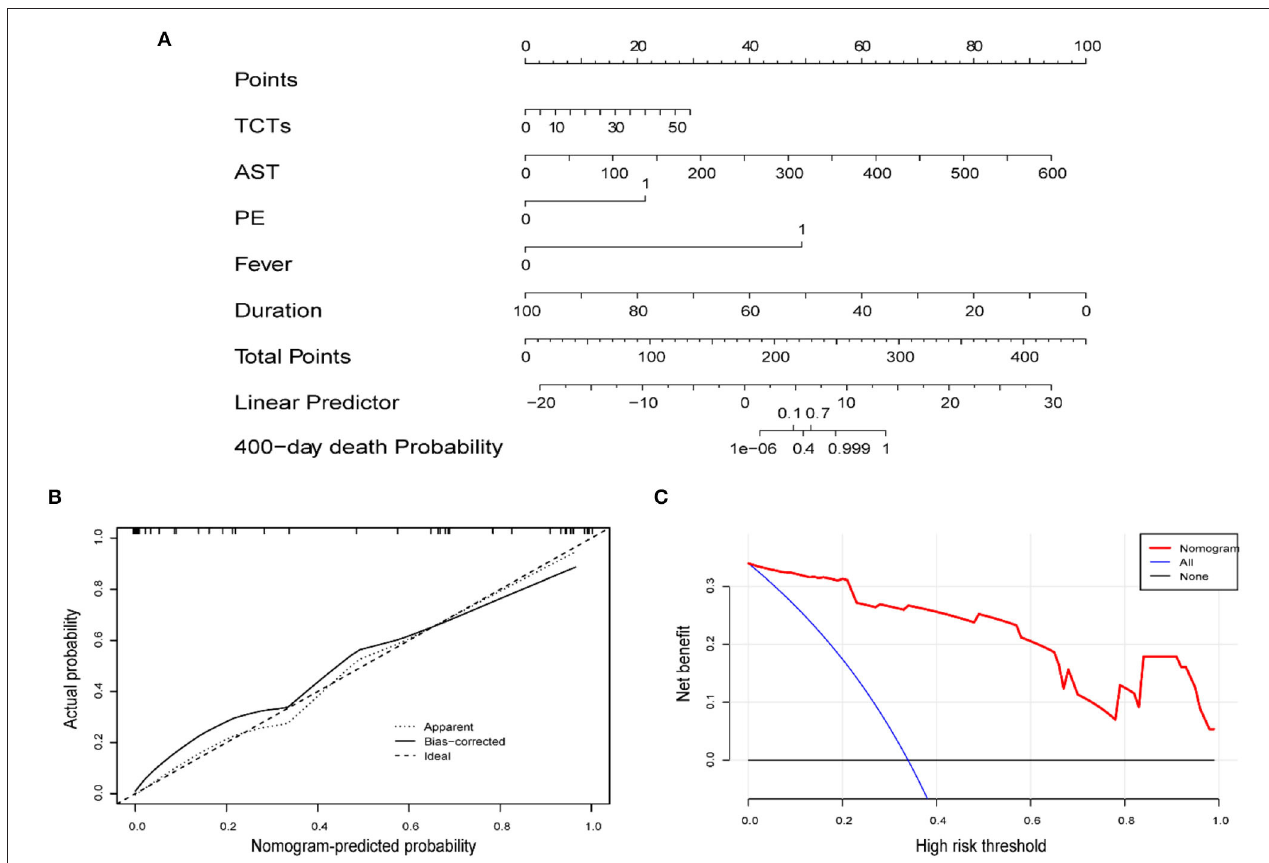
FIGURE 3 | (A) Nomogram predicting the prognosis of MDA5 + DM-ILD. (B) Calibration curve of the nomogram. (C) DCA of the